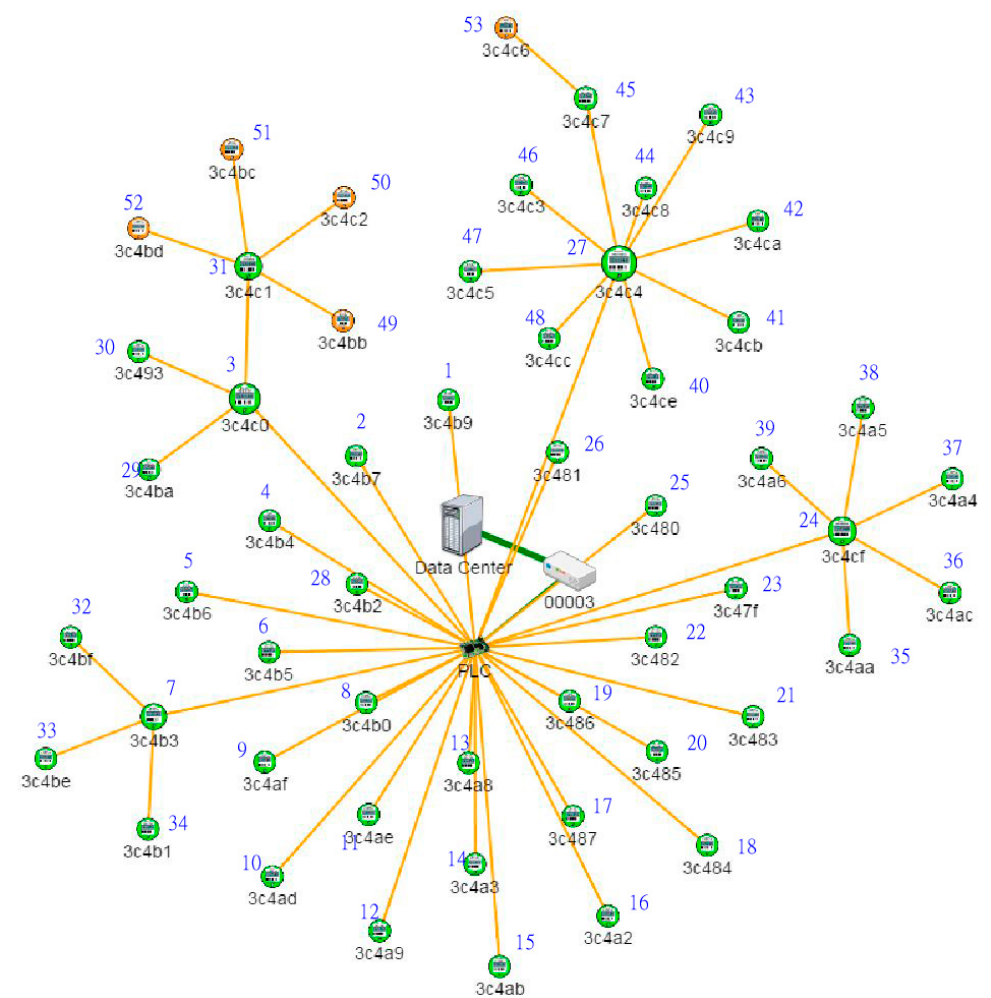
Figure 7. An Actual Small-Scale PLC-based AMI.